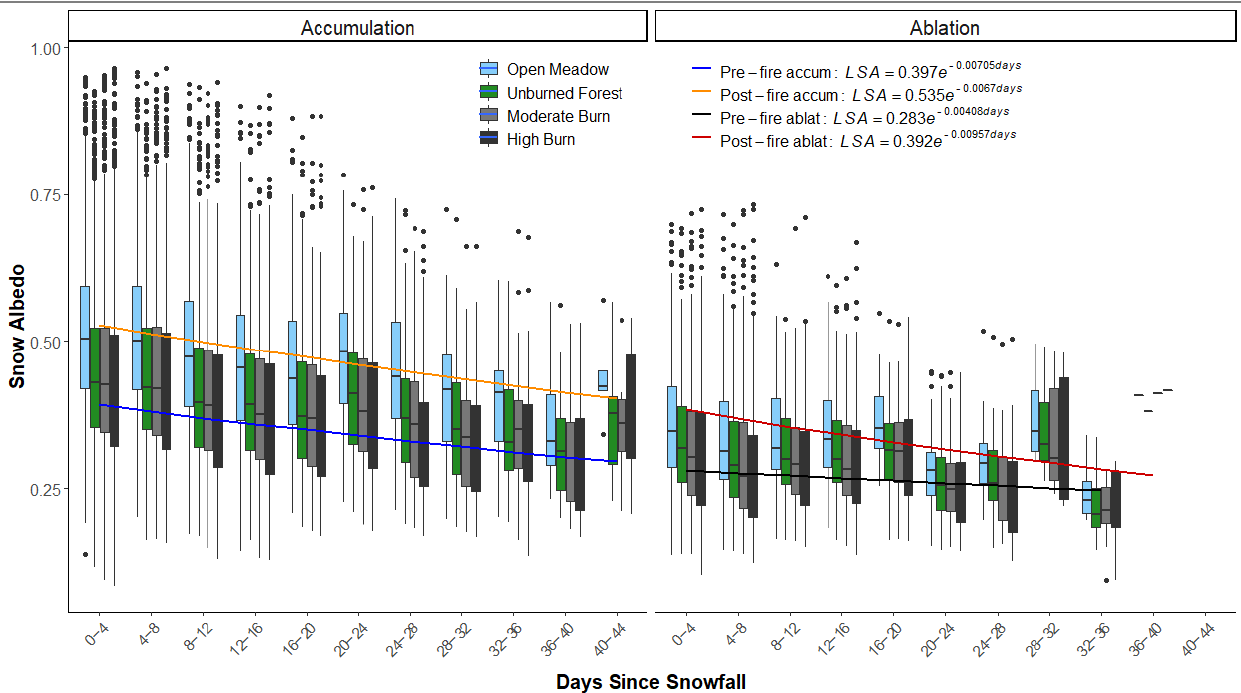
Figure 6. Pre- and post-fire landscape snow albedo decay during accumulation and ablation derived from MODIS data over days since snowfall > 5 cm derived from the average snowfall of all SNOTEL sites within the study domain. Box plots show the distribution of snow albedo pixels within burned forests for each 4-day period following a fresh snowfall.